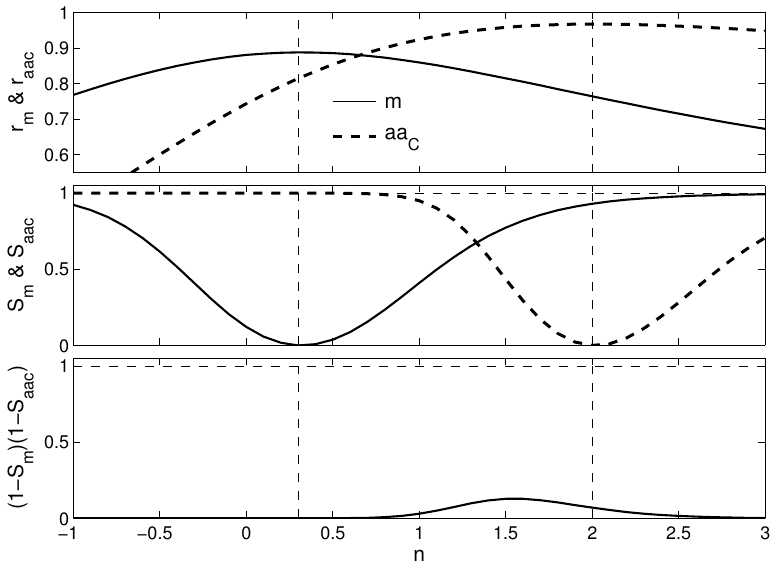
, dashed Figure 16: Top: Correlograms showing the correlation coefficients 𝑟 𝑎𝑎𝑐 (between 𝑎𝑎 𝐶 and 𝐵𝑉 𝑛 SW , solid line) as a function of the exponent 𝑛 . The vertical dashed lines line) and 𝑟 𝑚 (between 𝑚 and 𝐵𝑉 𝑛 SW mark the peaks at 𝑛 = 2 and 𝑛 = 0 . 3, respectively. Middle: the significances 𝑆 𝑎𝑎𝑐 and 𝑆 𝑚 (dashed and solid lines, respectively) of the differences between the correlations at general 𝑛 and the peak values, as evaluated using the Fischer-Z transform and (bottom) the joint probability (1 − 𝑆 𝑎𝑎𝑐 ) × (1 − 𝑆 𝑚 ). Image reproduced by permission from Lockwood et al. (2009d), copyright by